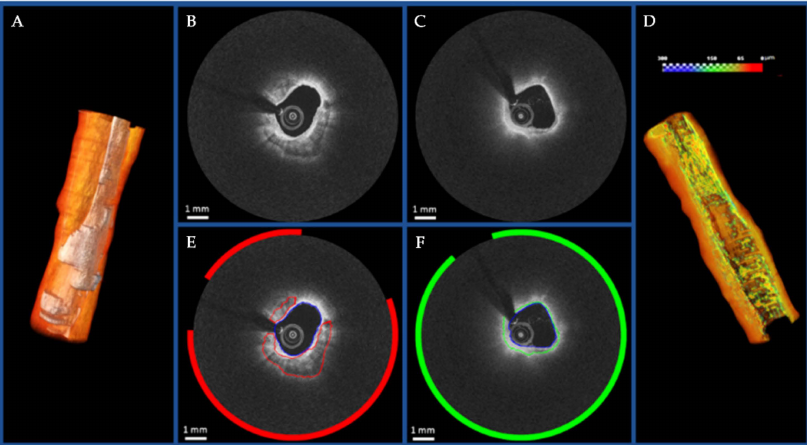
Figure 8. Visualization of the proof-of-concept automated segmentation and 3D rendering results for calcific ( A ) and lipidic ( D ) plaques. The original images and the corresponding automated segmentation for calcific lesion and fibrous cap over the lipid component are shown in ( B , E ) and ( C , F ), respectively. Reprinted from [115], with permission, under the Creative